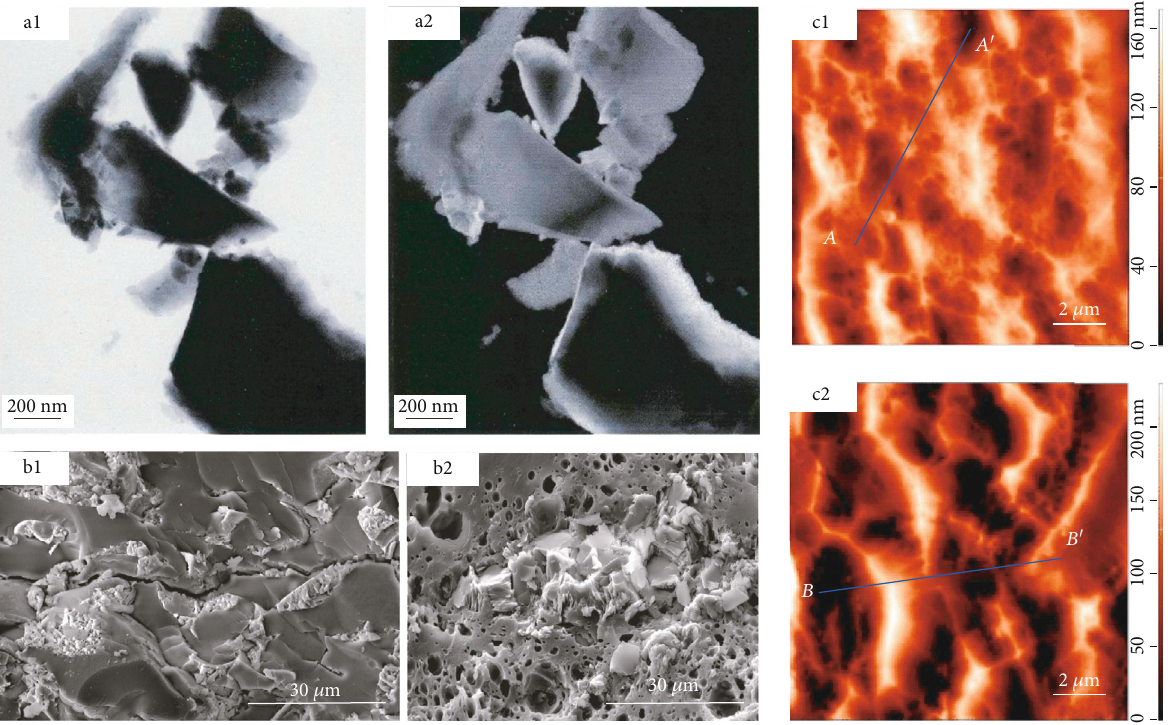
Figure 6: TEM images of anthracite grains (a1, a2), SEM images of di ff erently ranked coals (b1, b2), and 2D AFM images of di ff erent coal samples (c1, c2) (modi fi ed from Kwieci ń ska et al. [48], Liu et al. [49] and Zhao et al.